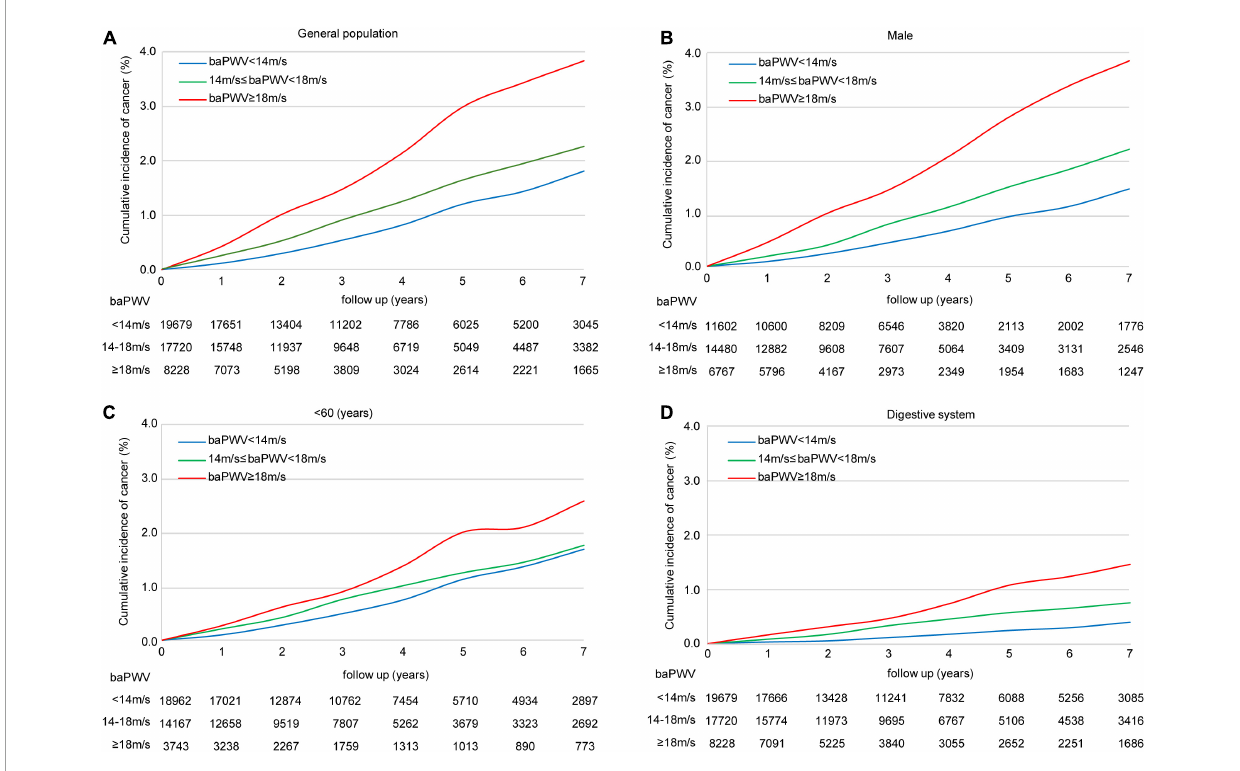
FIGURE3 The Kaplan-Meier survival curves for cancer incidence. Participants are categorized into three groups according to baPWV values. The Kaplan-Meier survival curves demonstrate a significant increase in cancer incidence in the entire cohort (A) male (B) and participants < 60 years (C) with a baPWV ≥ 18 m/s (all P < 0.001). The Kaplan-Meier survival curves demonstrate a significant increase in digestive cancer incidence in the entire cohort (D) with a baPWV ≥ 18 m/s (all P < 0.001). baPWV, Brachial-ankle pulse wave velocity.